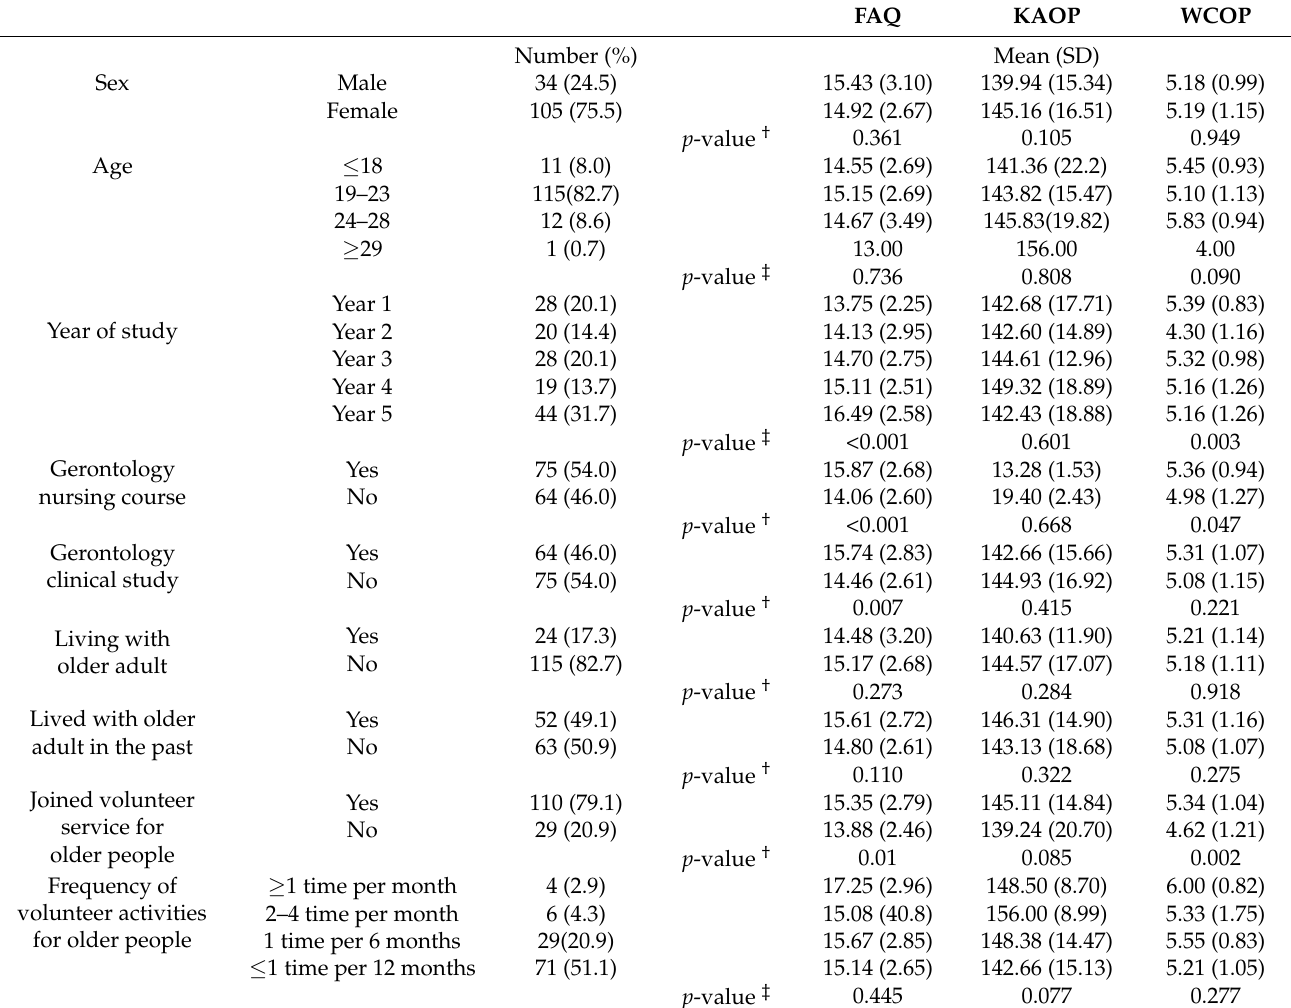
Table 1. Demographic information and mean scores for knowledge, attitudes, and care willingness (N = 139).